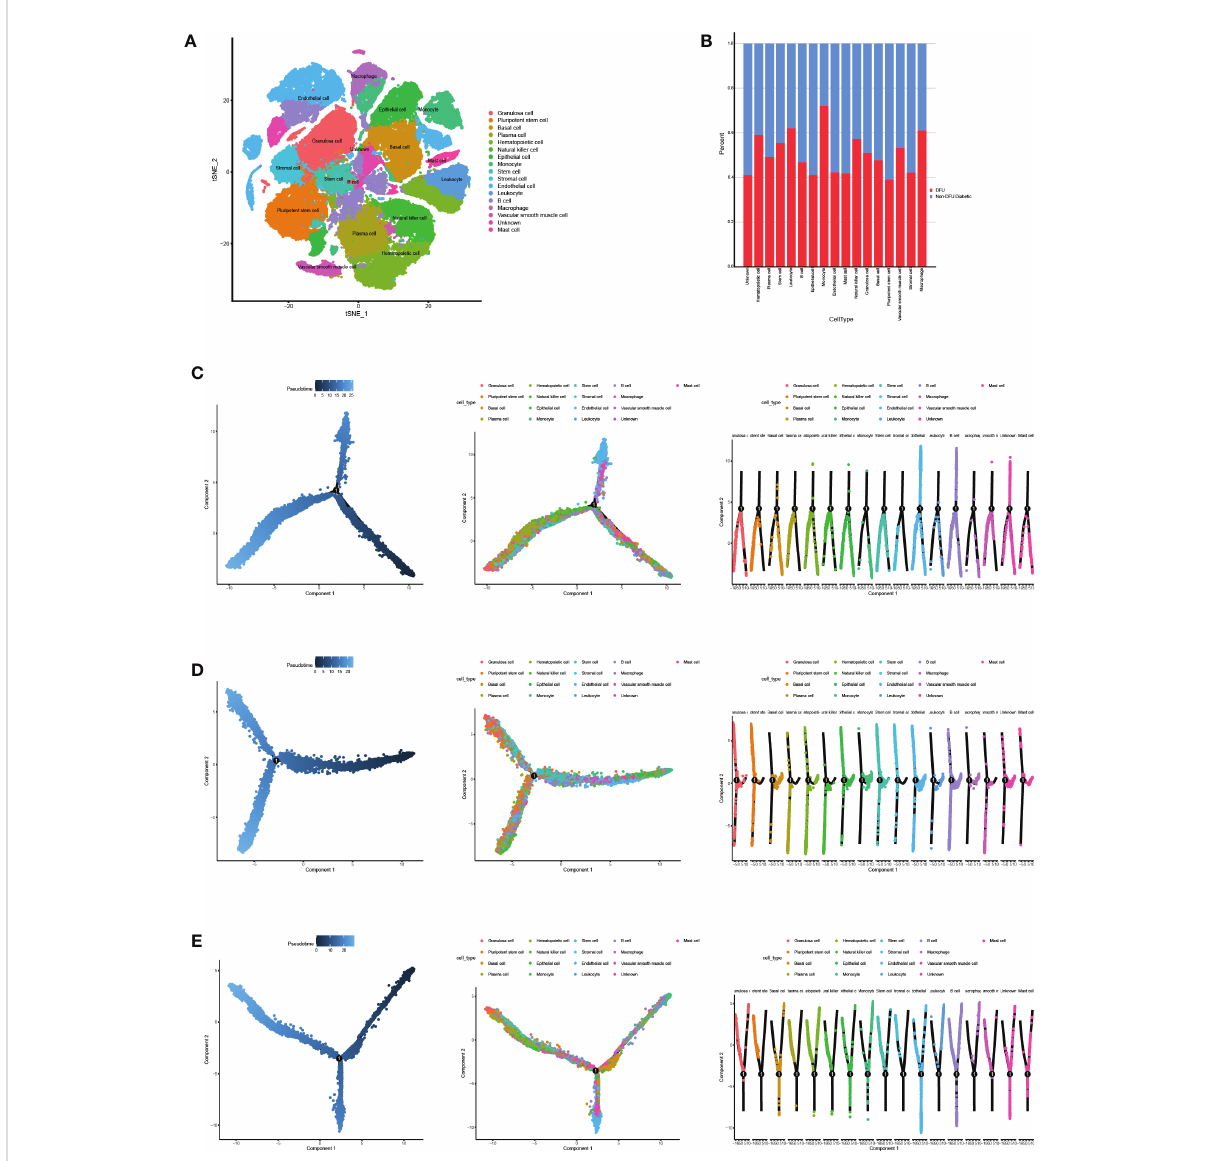
FIGURE 4 Cell annotation and pseudotime analysis. (A) Classifying the different cells on the t-SNE plots. (B) The heatmap shows the annotated cell abundance within different disease samples (DFUs and Non DFUs diabetic). (C-E) Pseudo-time analysis of DFUs healing, non-healing samples and togethers. Pseudotime, cell development